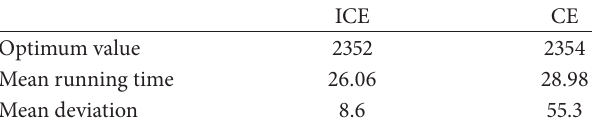
Table 1: Comparison of results by ICE and CE. Table 2: Optimum charge plans obtained by ICE and